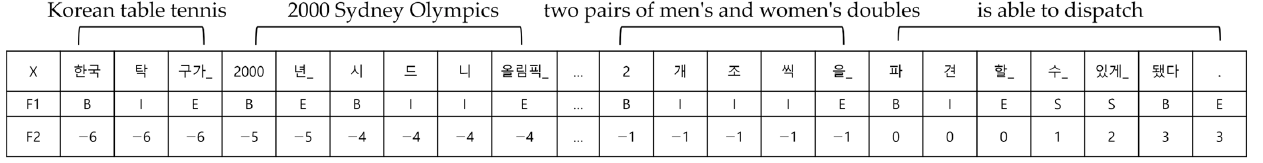
Figure 3. Example of a text feature.